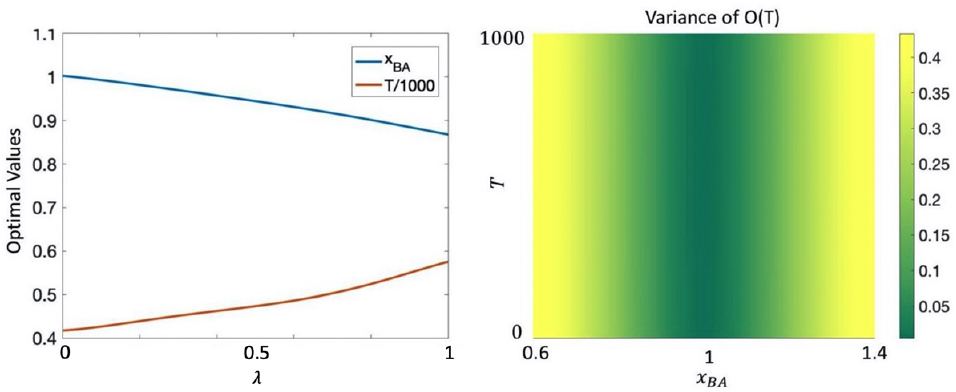
Figure 4. Optimal values for x BA and T and variance of the predictive Gaussian process. ( Left: ) Optimal values of x BA and T for different values of λ . ( Right: ) Variance of O ( T ) after training (Equation (2)) as 1000 a function of x BA and T . The variance is minimized for x BA ∼ 1. This is due to the fact that all training data have x BA =